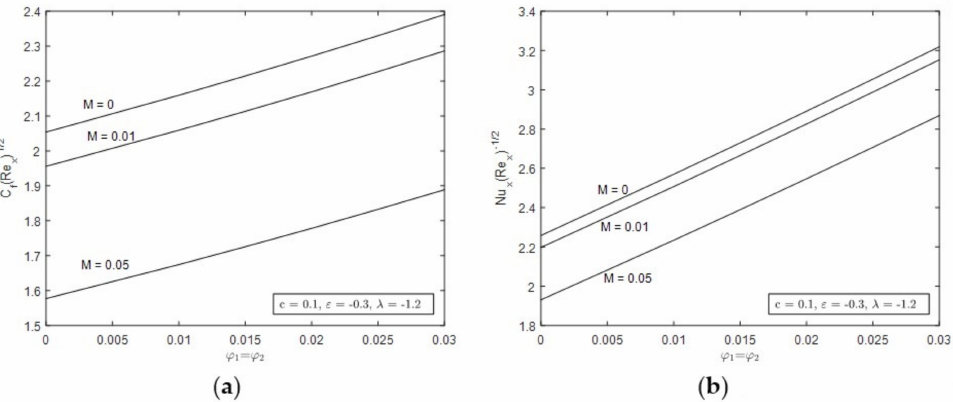
Figure 8. ( a ) Variation of C f with ϕ for different values of M . ( b ) Variation of Nu x with ϕ for different values of M .